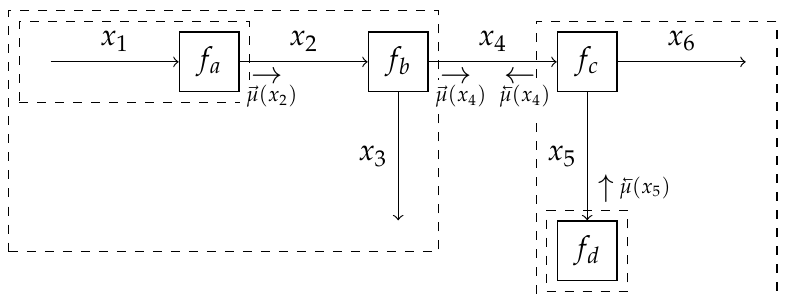
Figure 7. Forney-style factor graph of (17) with sum-product messages as indicated in (19) for the calculation of the marginal distribution of x 4 .